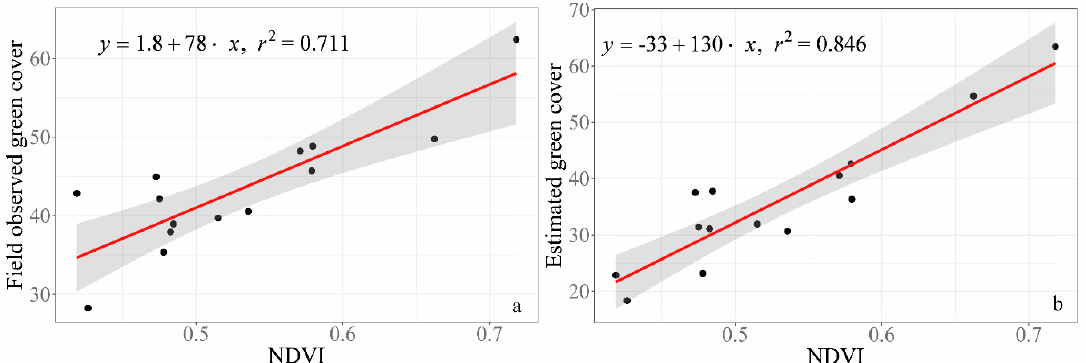
Figure 5. Validation of RGB extracted green cover. ( a ) The relationship between normalized vegetation index (NDVI) and visual estimated GV cover (i.e., field observed green cover). ( b ) The relationship between NDVI and GV cover extracted by the method of this study.